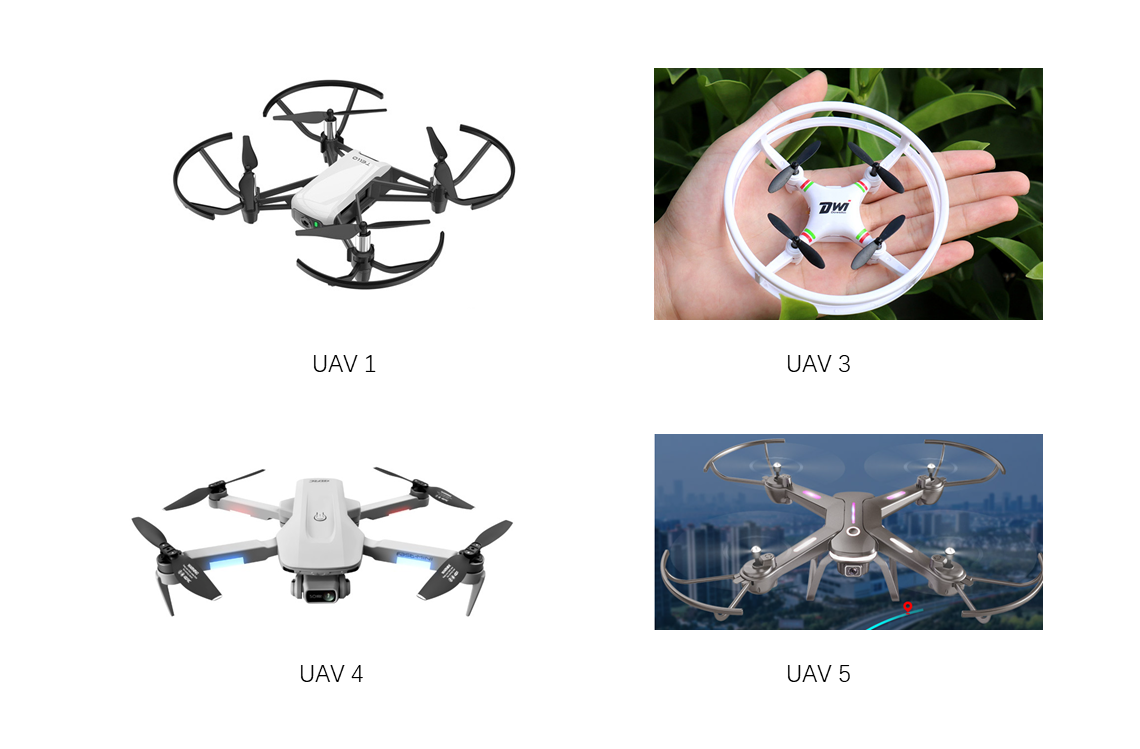
Figure 7. Four different models of UAVs.